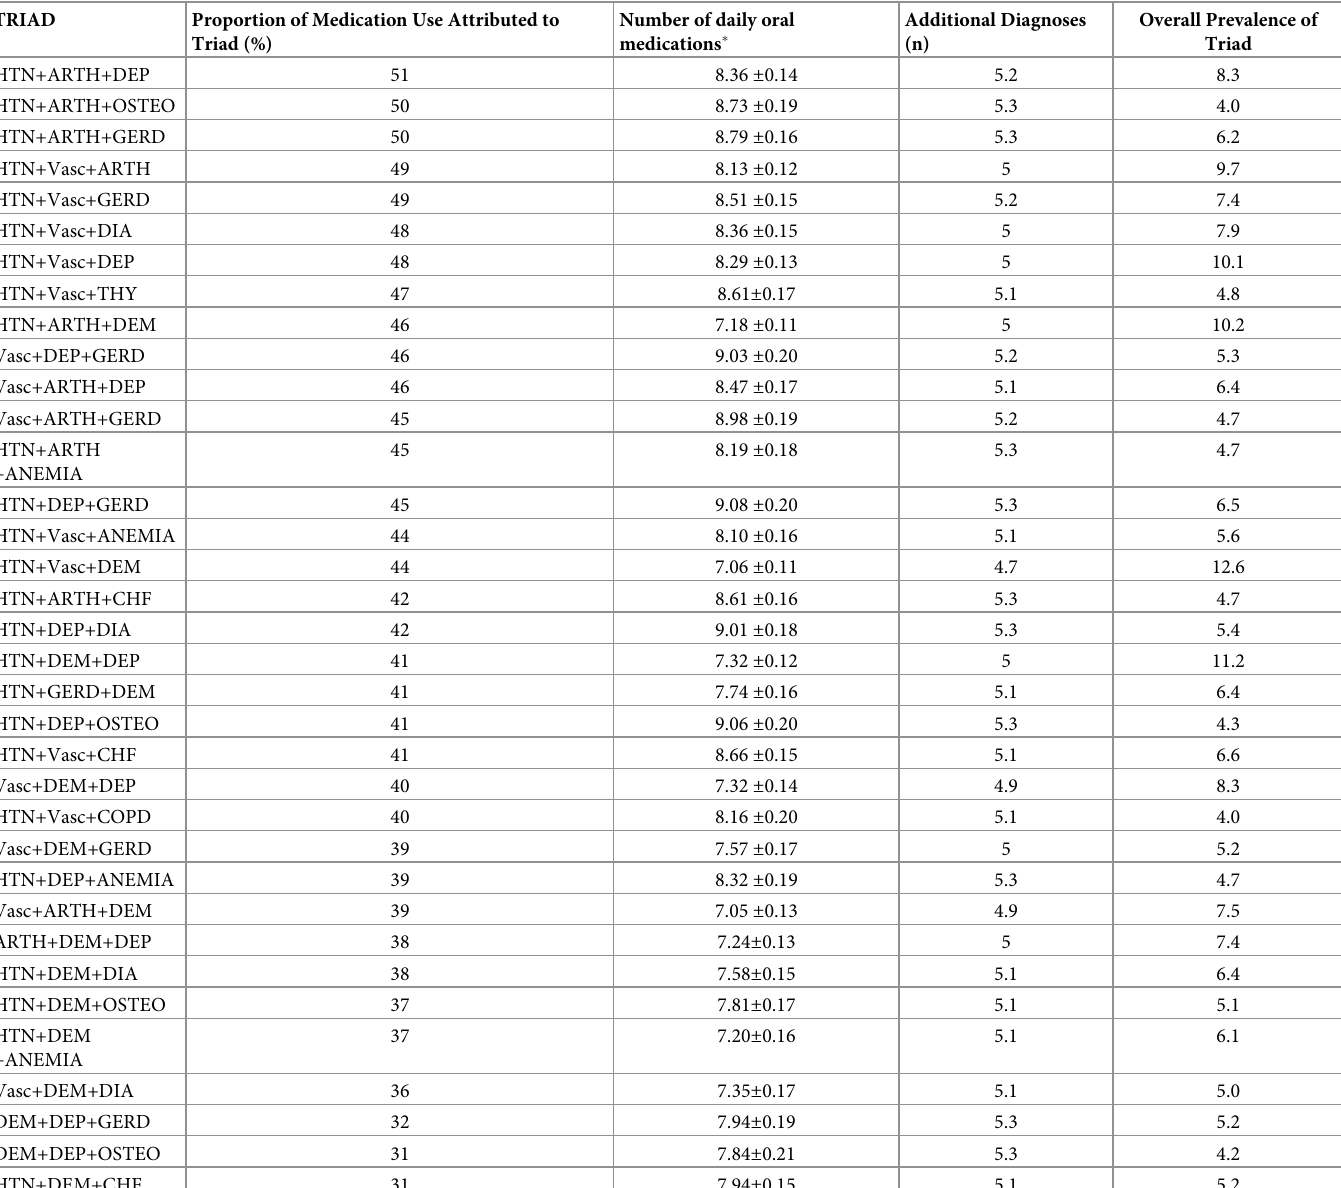
Table 4. Medication usage attributable to common chronic disease